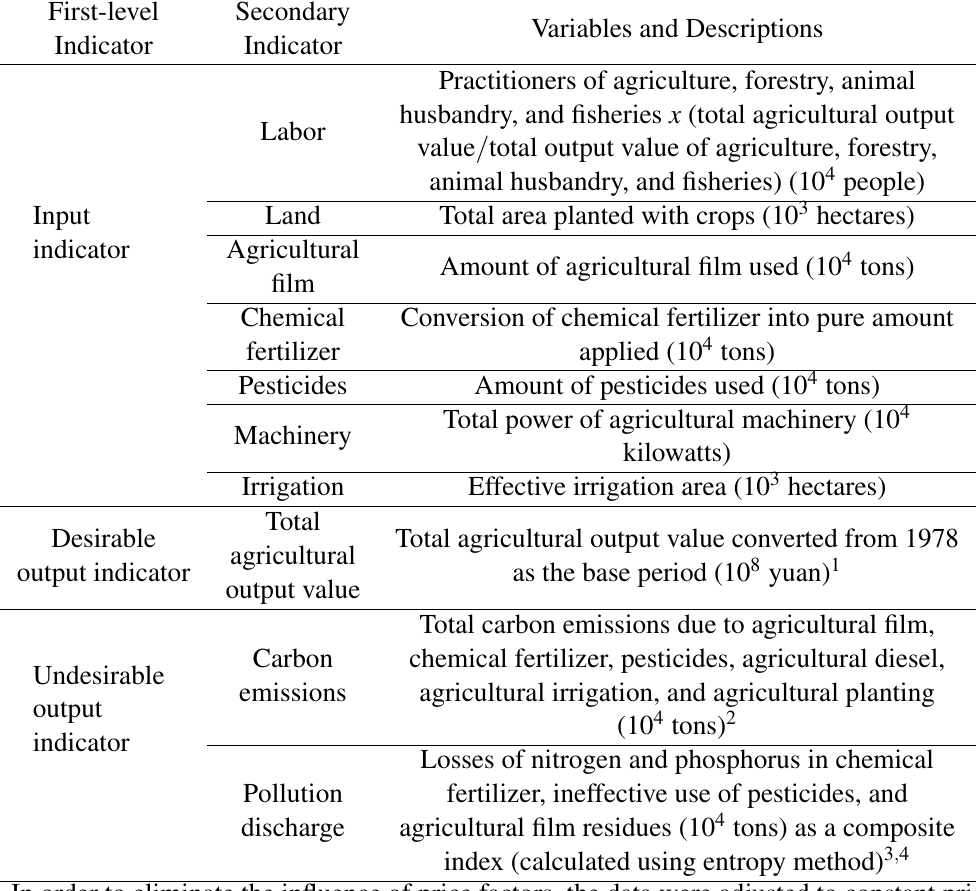
Table 1 Evaluation indexes for agricultural